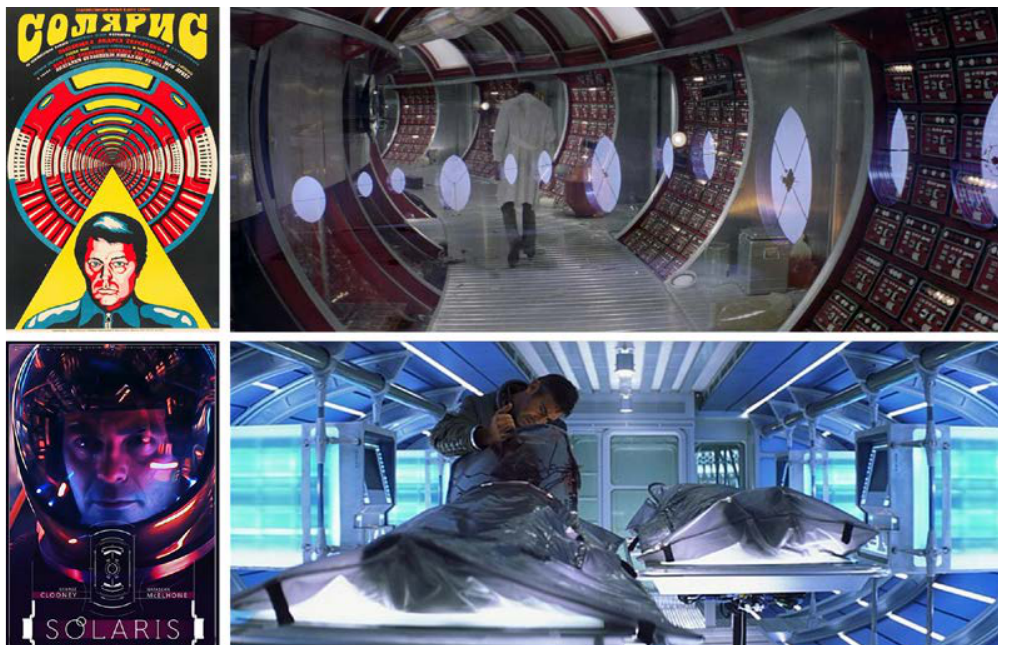
Fig. 9 Andrej Tarkovskij, Solaris , 1972 (above); Steven Soderbergh, Solaris , 2002